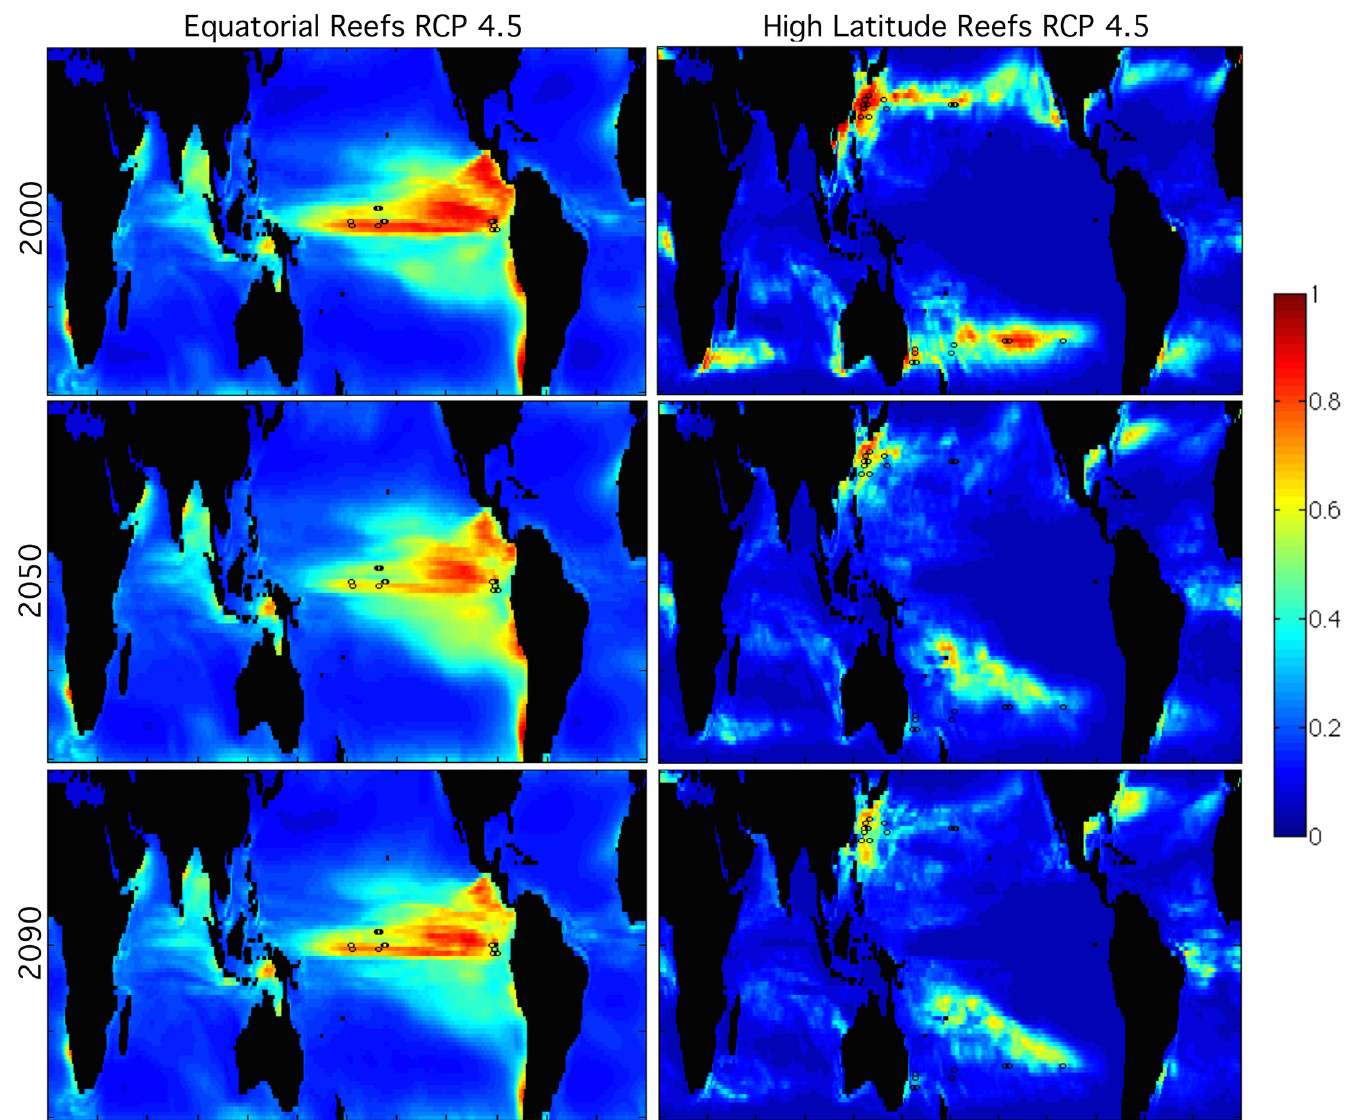
Fig 4. Maps Showing Robust Prevalence of Marginal Coral Reef Habitats in Future Climate Projections. Habitat suitability calculated from Maxent is shown as maps above for marginal reefs. These reefs show extended habitat in climate change scenarios as well as robust prevalence at original coral reef locations. Data from RCP4.5 is shown here. The Equatorial Reefs are in the left column and High Latitude Reefs are in the right column, shown for years 2000 (top), 2050 (middle), and 2090 (bottom). The color scale indicates the level of habitat suitability from marginal (blue) to highly suitable (yellow/red). Landmasses are shown in black. Coral reef locations used in this calculation are mapped as black circles.